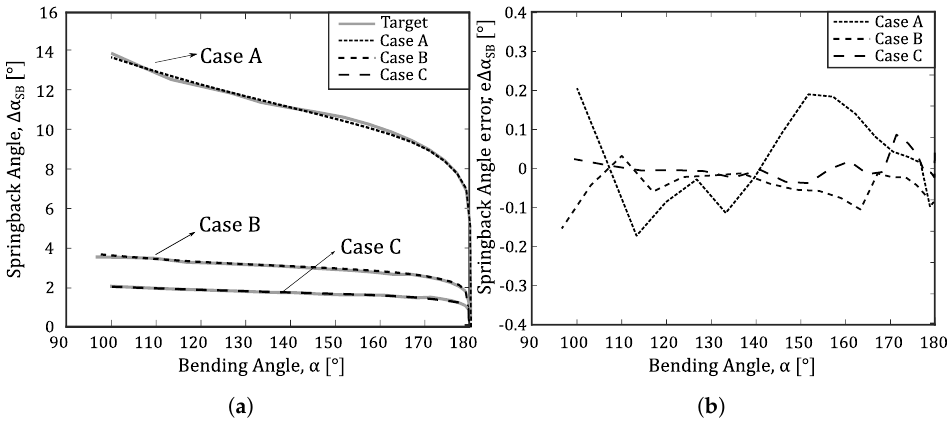
Figure 23. Sprinback analysis for cases A, B, C: ( a ) springback angle ( ∆ α SB ) and the corresponding expected value (Target) as a function of required bending angle ( α ); ( b ) springback angle error ( e ∆ α SB ) for each case as a function of required bending angle ( α